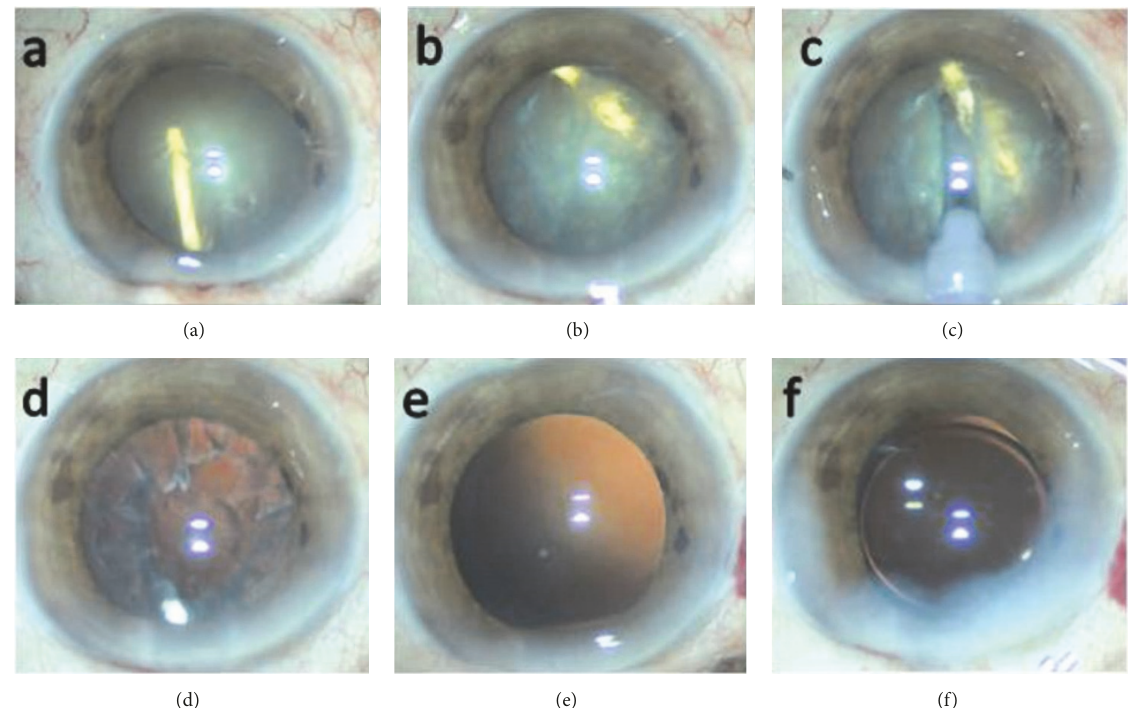
Figure 3: (a) Completed anterior continuous curvilinear capsulorrhexis, (b) image of intralenticular Ozurdex rotated with nucleus, (c) creating a groove with phaco probe, (d) cortical remnants, (e) image of intact posterior capsule, and (f) intraocular lens